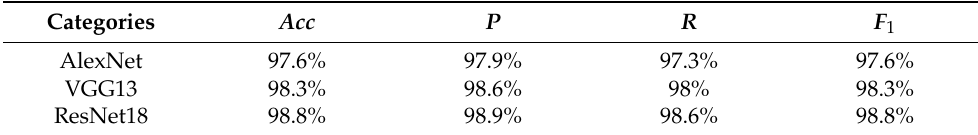
Table 2. Experimental